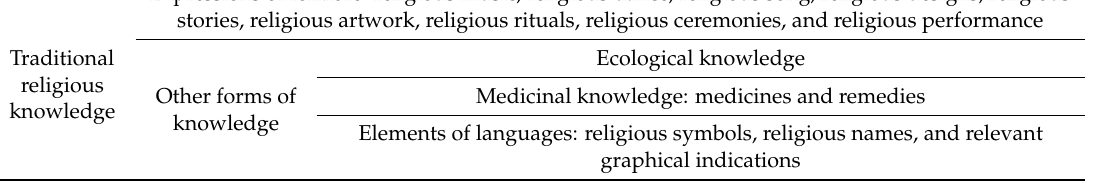
Table 1. Main forms of traditional religious